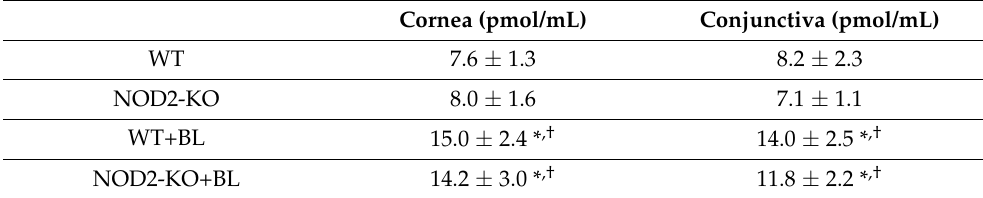
Table 1. ELISA for MDA in the cornea and conjunctiva of WT, NOD2-KO, WT+BL, and NOD2-KO+BL groups, after 10 days of blue light